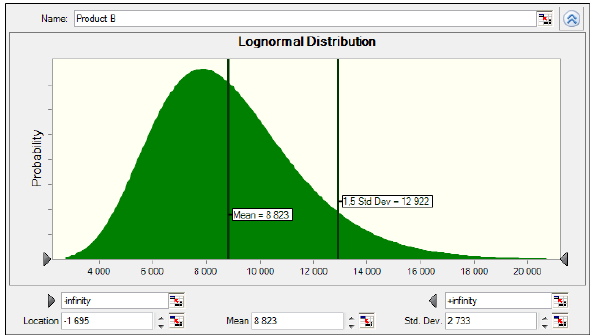
Figure 6: Distribution function for sale of product B.